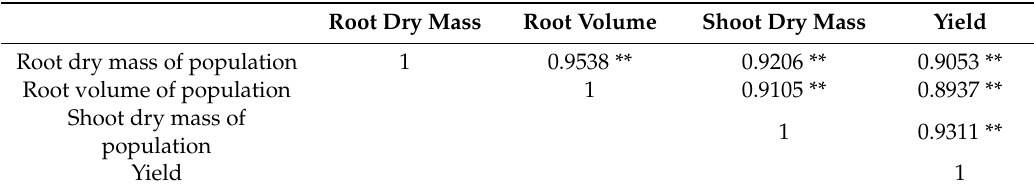
Table 9. Pearson correlation coe ffi cients between grain yield and root / shoot systems